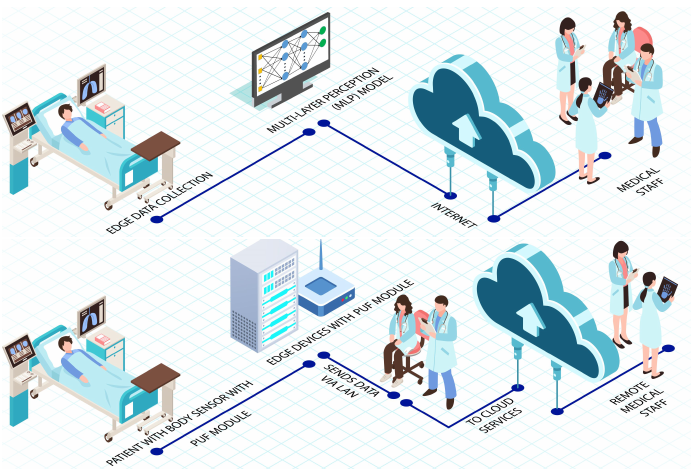
Figure 9. Framework of multilayer security scheme for implantable medical devices [111] and PUF-based energy-efficient authentication IoMT